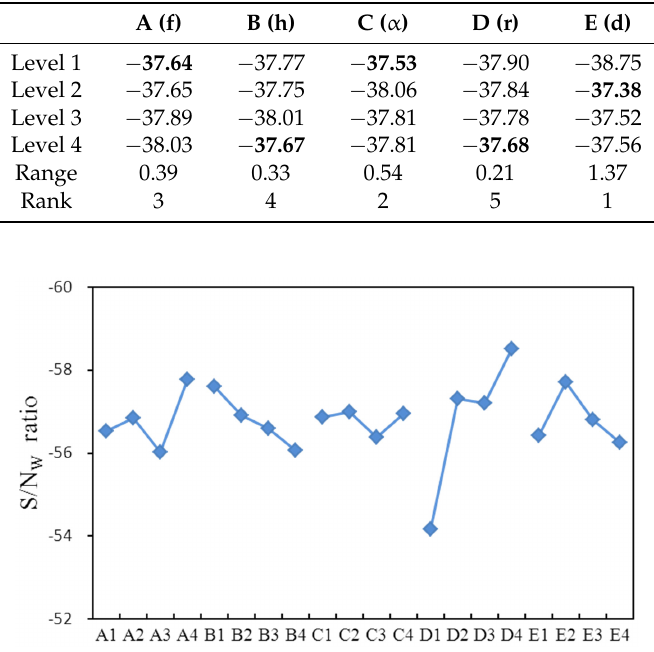
Figure 16. Response graph of S / N W ratios over five factors (A–D) and four levels (1–4).